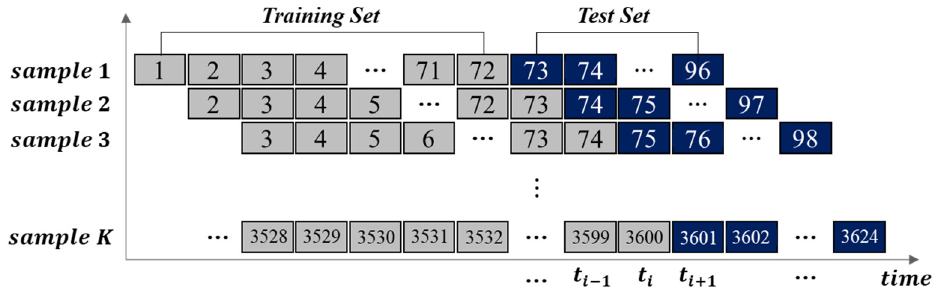
Figure 13. Visual representation of the cross-validation methods used for model evaluation based on a fixed window rolling forecast.